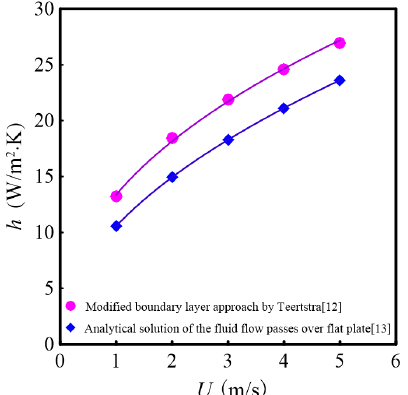
Fig. 4. Influence of inlet wind speed on the heat transfer coefficient